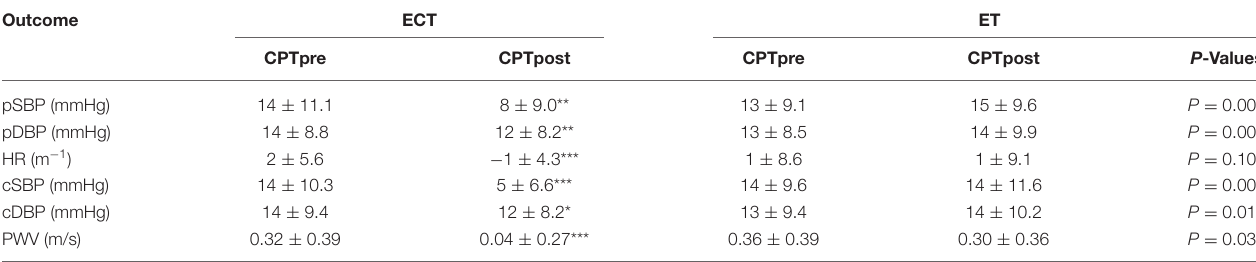
TABLE 4 | Hemodynamic responses to the cold pressor test before and 45min after training in the ExerCube and endurance training. Outcome ECT ET CPTpre CPTpost CPTpre